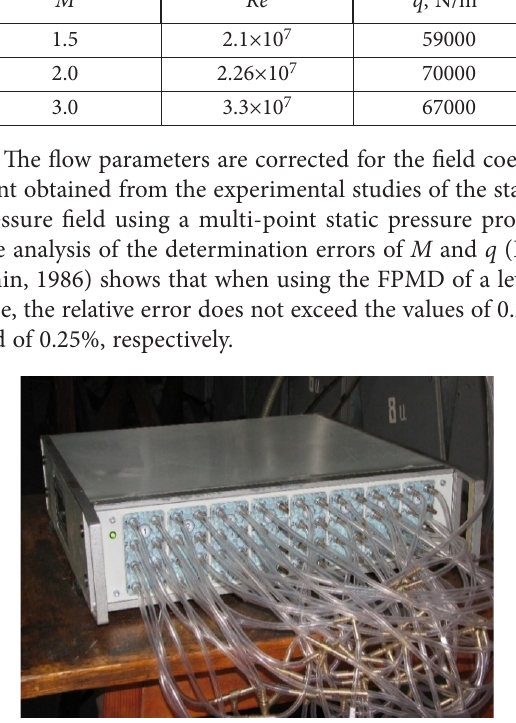
Figure 9. Measurement module of wind tunnel pressure Figure 10. Hermitised pneumatic connectors of